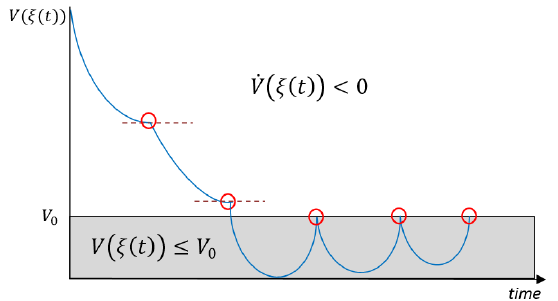
Figure 2. Description of the Theorem 1 triggering condition (16). If the Lyapunov function is greater than V 0 , the system is updated every time the derivative of the Lyapunov function is non-negative. If the system converges to the invariant set defined by V 0 , the system is triggered only when the Lyapunov function reaches the threshold V 0